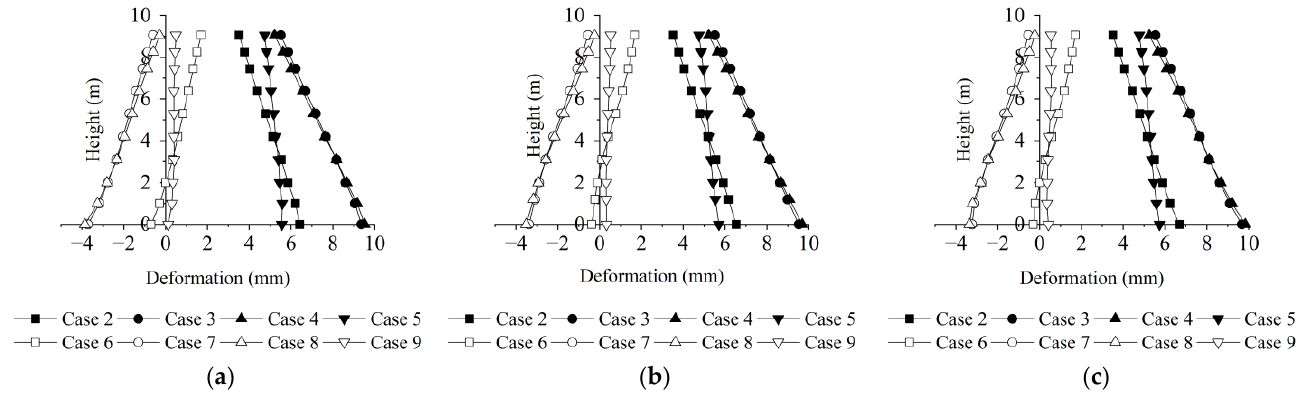
Figure 11. Lateral deformation of structural wall subjected to asymmetric construction: ( a ) northern wall, ( b ) middle wall and ( c ) southern wall (unit: mm).